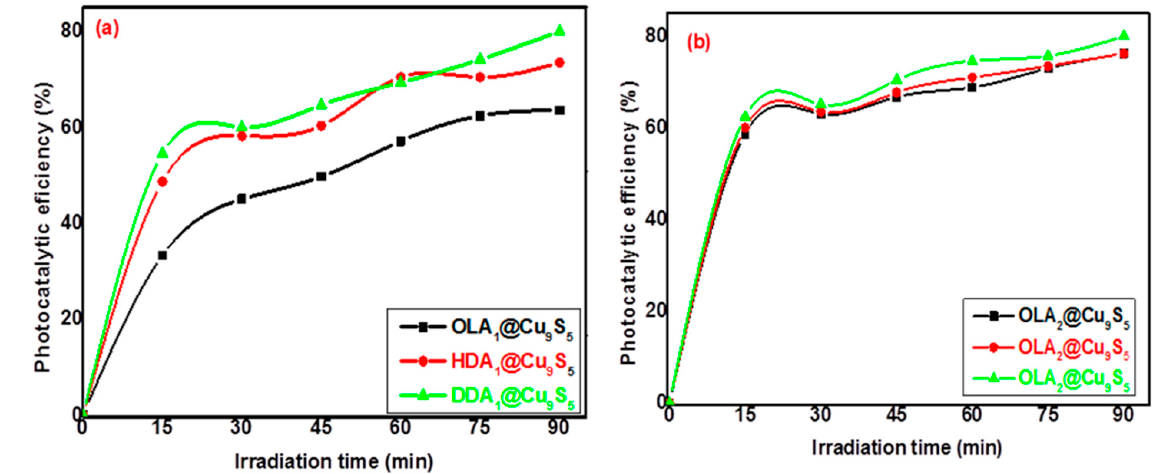
Table 4. Degradation efficiencies of OLA@Cu 9 S 5 , HDA@Cu 9 S 5 , and DDA@Cu 9 S 5 NPs obtained at 230 °C using complexes 1 and 2.